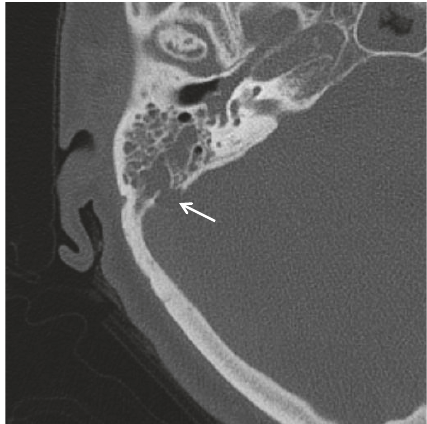
Figure 4: Axial CT brain demonstrating pneumocephalus in the posterior cranial fossa